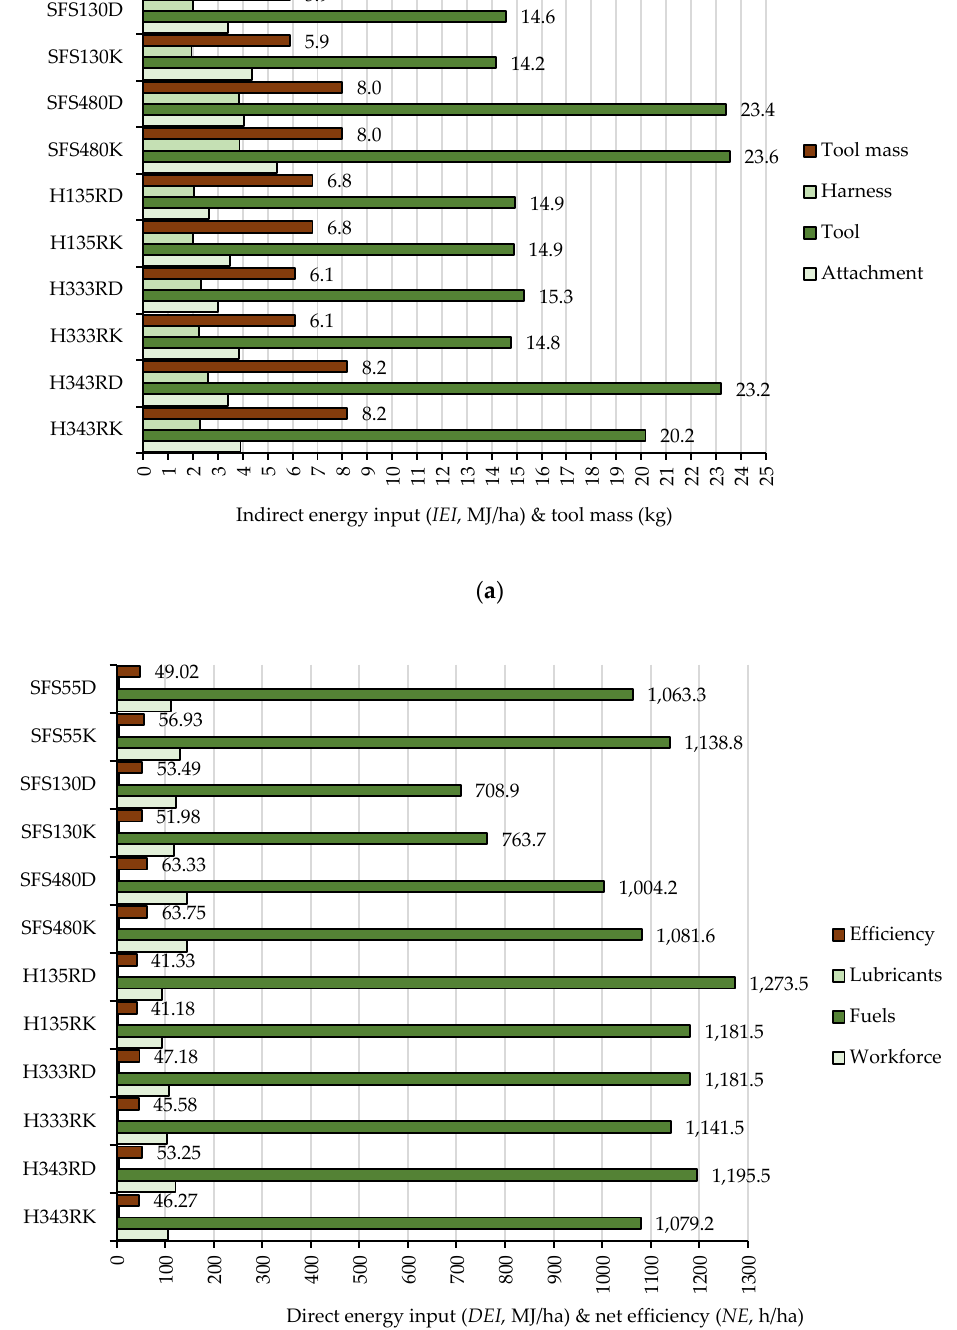
Figure 4. Inter-treatment variation of indirect energy inputs ( IEI , MJ/ha) and direct energy inputs ( DEI , MJ/ha) plotted against tool masses ( a ) and operational efficiency ( b ), respectively.